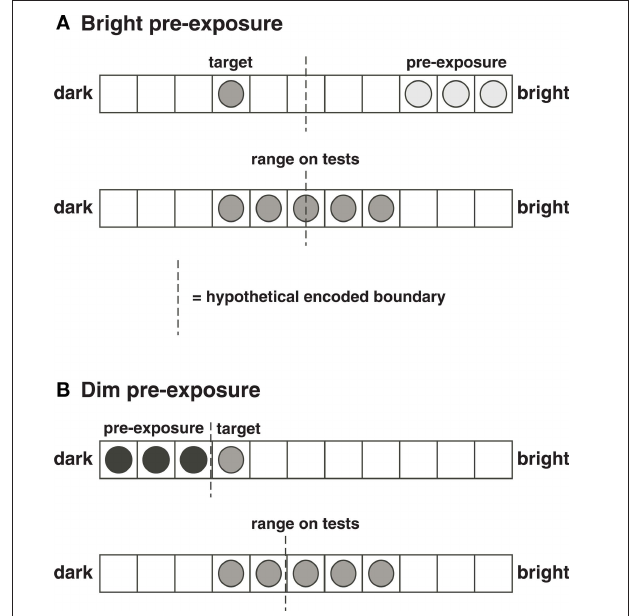
Figure 6 | explanation of some of Newlin et al.’s (1978, experiment 1) data. (A) A condition in which participants were first pre-exposed to bright stimuli, and then presented a target at brightness level 4 (top, 1 = dimmest, 11 = brightest). We suppose that the subjects encodes a boundary separating two categories, with the target coded as being in the dim category. The categorical code provides additional information to the encoding of the metric value of the target brightness. On tests (bottom), the range of stimuli is more or less centered on the category boundary, so that the boundary does not shift during tests, and a “correct” generalization gradient peaking at 4 is found (Newlin et al.’s Figure 1). (B) A condition in which participants were first exposed to dim stimuli, and then presented a target at brightness 4 (top). We suppose that the participant would encode a boundary somewhere between 3 and 4. On tests (bottom), the range serves to shift the encoded category boundary toward the brighter end, thus causing large range effects (Newlin et al.’s Figure 1). The shift occurs because the boundary was somewhere in the middle of the range before tests (in pre-exposure and target training), and the subject is relying on the “middle of the range” description (a categorical code) in part in determining the boundary during